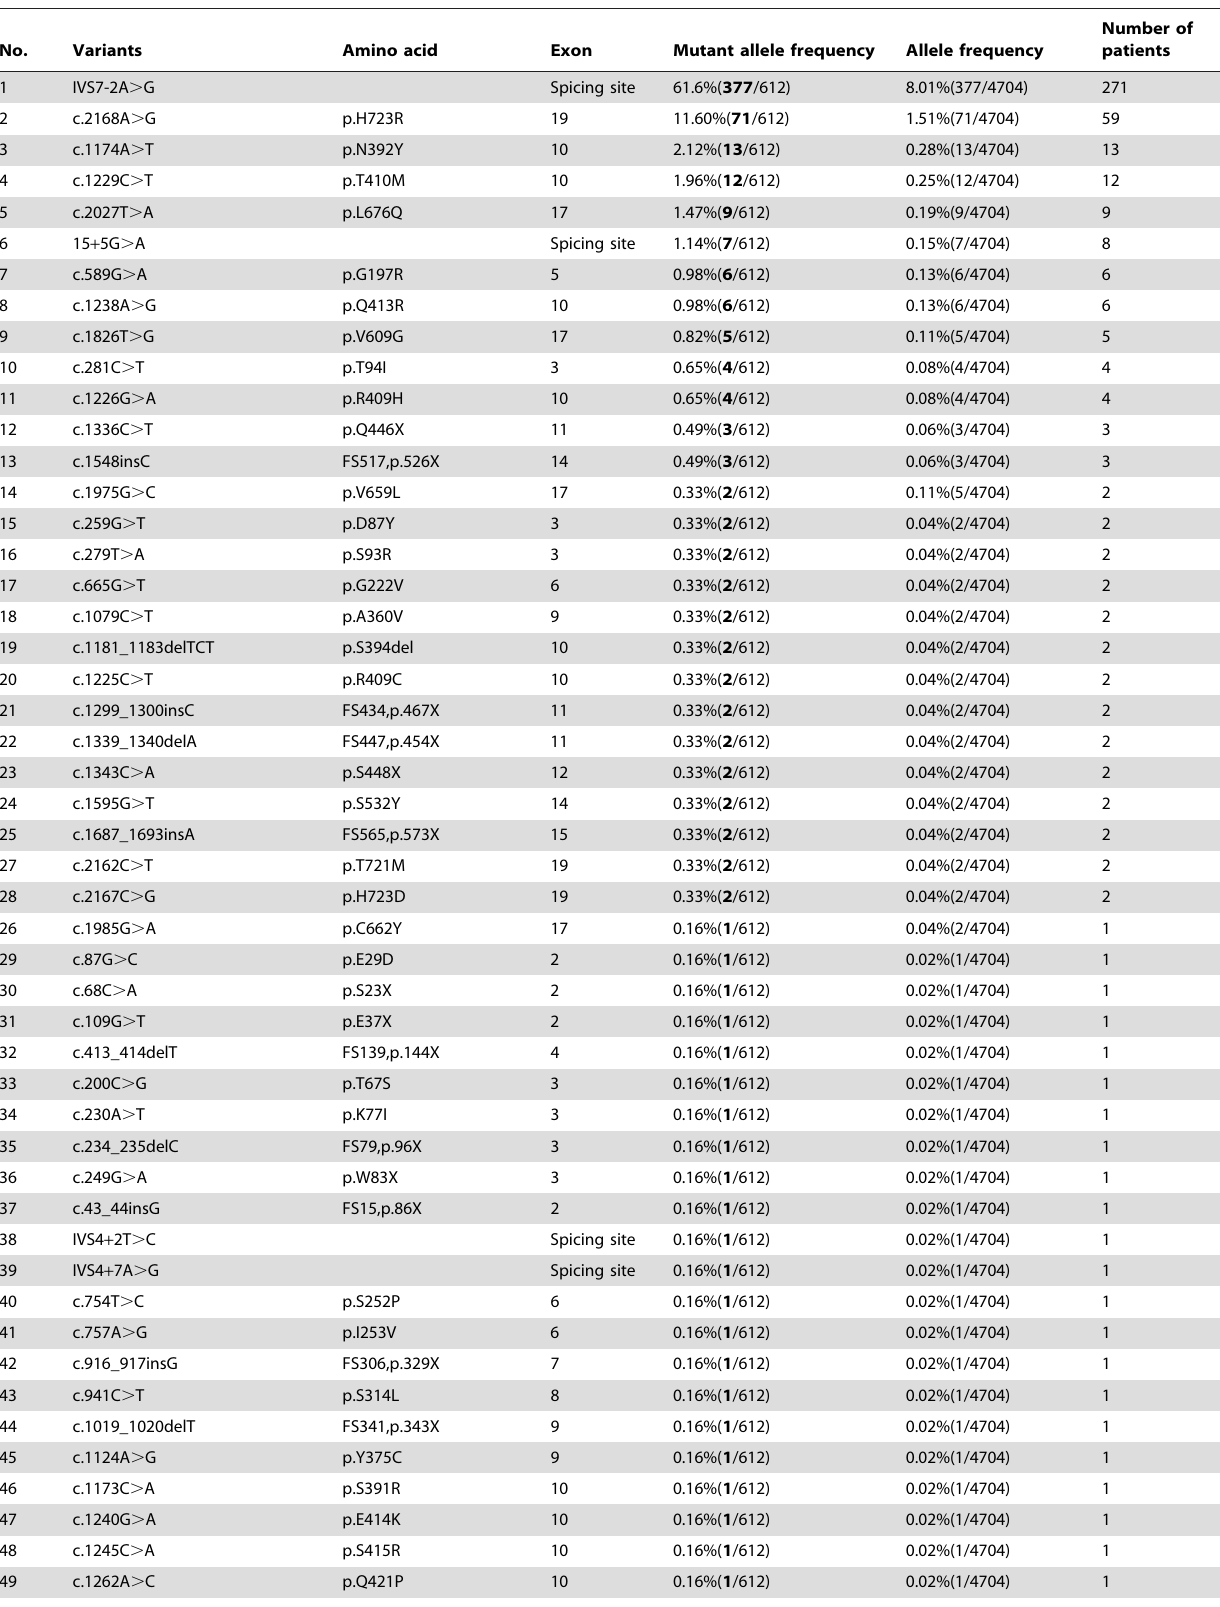
Table 1. Variants information of SLC26A4 in Chinese